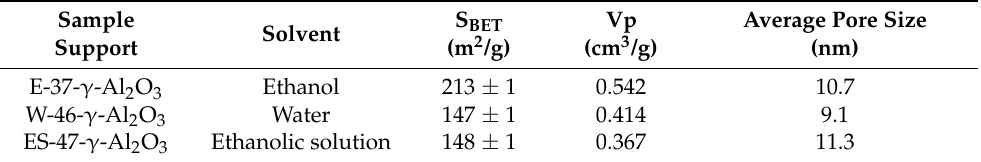
Table 1. Textural properties of the mesoporous γ -Al 2 O 3 supports.